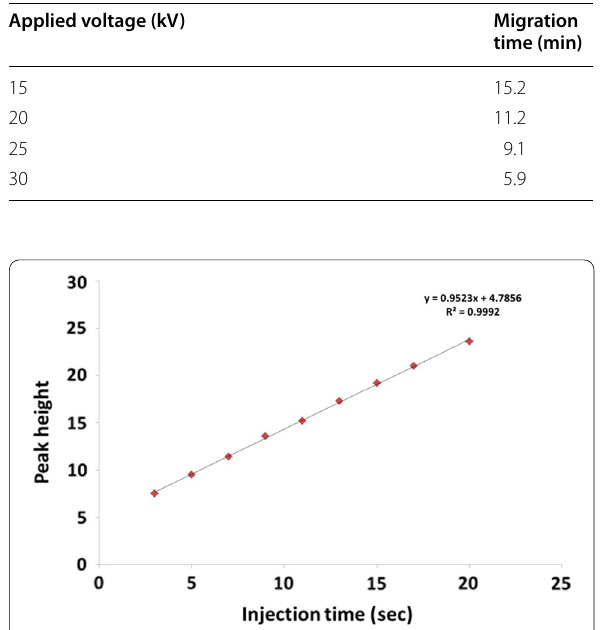
Fig. 3 Effect of injection time on the linearity of TIG in intravenous infusion solution at 245